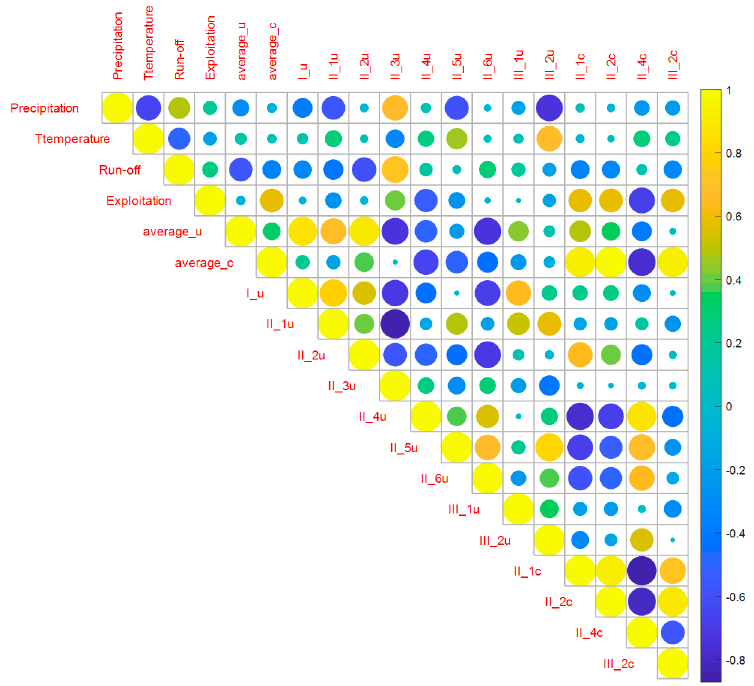
Figure 11. Correlation between various influencing factors of groundwater depth.